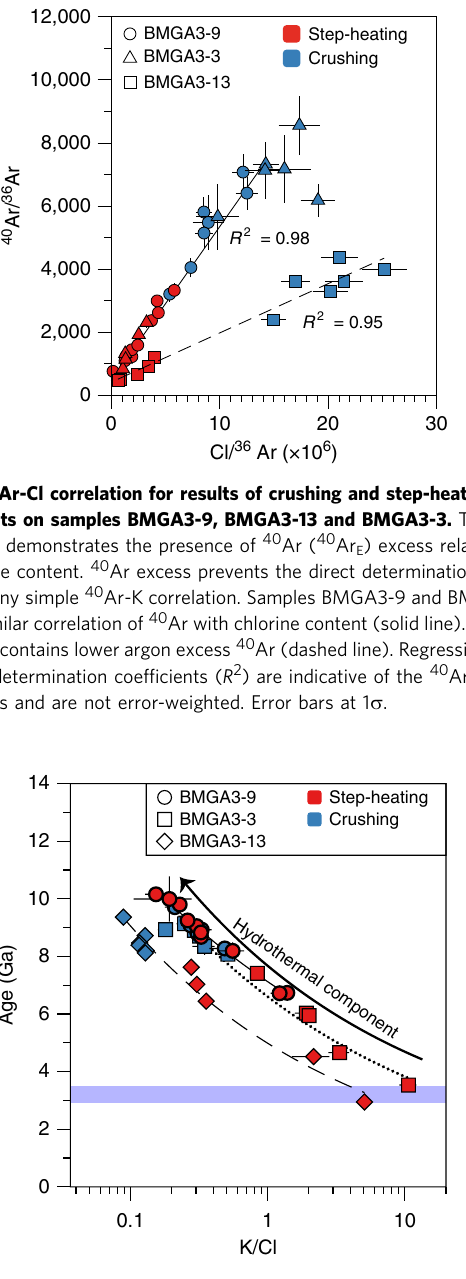
Figure 2 | Apparent ages versus the K/Cl ratio. Most ages are anomalously high ( 4 4.56Ga) due to the presence of excess argon linked to a hydrothermal component rich in Cl (low K/Cl). For elevated K/Cl rato ( 4 3) apparent ages decrease towards more realistic values between 3 and 3.5Ga (purple range). The solid, dotted and dashed curves schematically represent the evolution of ages with the K/Cl ratio for samples BMGA3-3, BMGA3-9 and BMGA3-13, respectively. Errors bars are at 1 s (Fig. 1 and Supplementary Table 1). This method uses the 40 Ar E /Cl derived from crushing data to correct step-heating data for the 40 Ar E component (Methods). This leads to a similar, but less precise, age of 3.5 ± 1.0 Ga ( ± 2 s , s.d., mean square weighted deviation (MSWD) ¼ 1.06). The initial atmospheric 40 Ar/ 36 Ar ratios of sample BMGA3-13, computed for ages varying between 3.2 and 3.4 Ga (see above) have values ranging from 178 to 202 with a mean of 190 ± 12 ( ± 2 s , s.d.) (Supplementary Fig. 3). This value is a minimum value for the Archean atmospheric 40 Ar/ 36 Ar